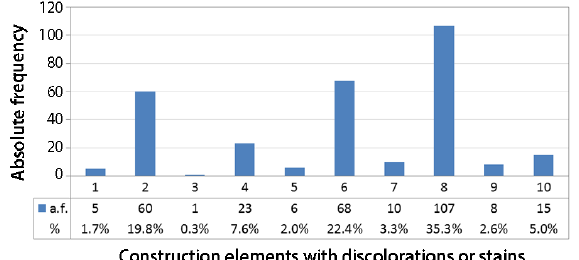
Fig. 28. Absolute frequency (a.f.) and percentage of construction elements with discolorations or stains (A3)